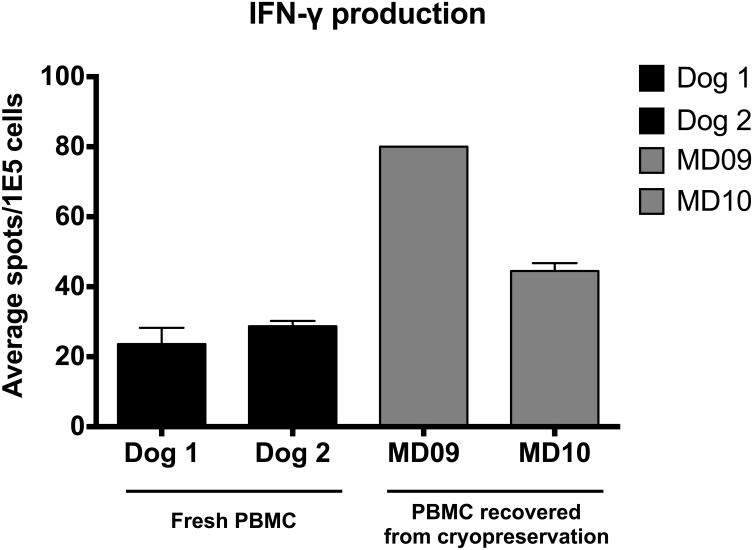
Interferon-γ (IFN-γ) production of fresh and cryopreserved canine PBMC in response to ConA.Fresh PBMC from two unaffected dogs (Dog 1 and Dog 2) and PBMC recovered from cryopreservation from two unaffected dogs (MD 09 and MD 10) were stimulated with Con A (2.5 μg/mL). Bar graphs shows IFN-γ production (mean ± SD of the number of spots per 105 cells). No spots were seen from any of the unstimulated PBMC samples in this assay.